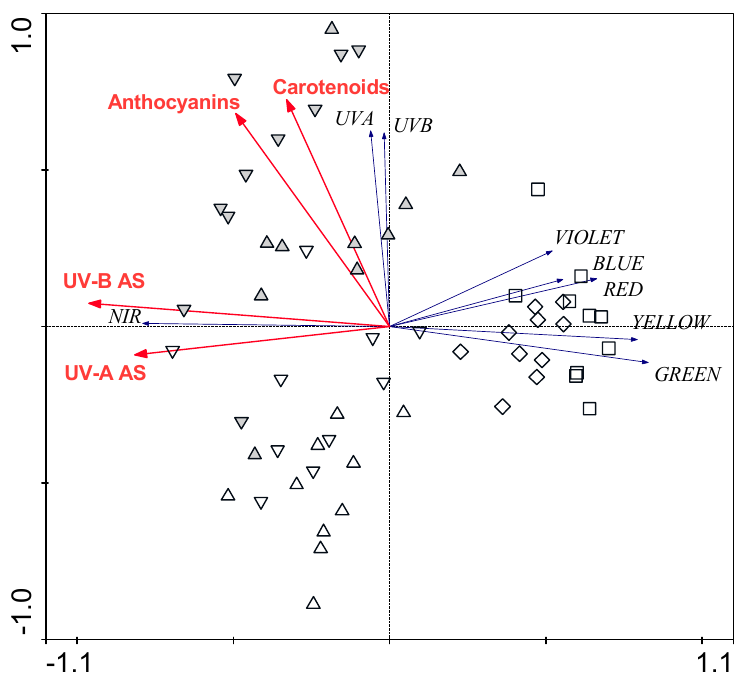
Figure 4. Redundancy analysis ordination diagram showing the strengths of the associations between the leaf biochemical parameters (i.e., carotenoids, UVA- and UVB-absorbing substances and anthocyanins) and the regions of the transmittance spectra for the leaves of the vines and willows. White diamonds, E. lobata ; white squares, P. quinquefolia ; white upright triangles, S. fragilis ; gray upright triangles, S. fragilis shaded by P. quinquefolia ; white upside-down triangles, S. caprea ; gray upside-down-triangles, S. caprea shaded by E. lobata . Only the significant leaf parameters are shown.